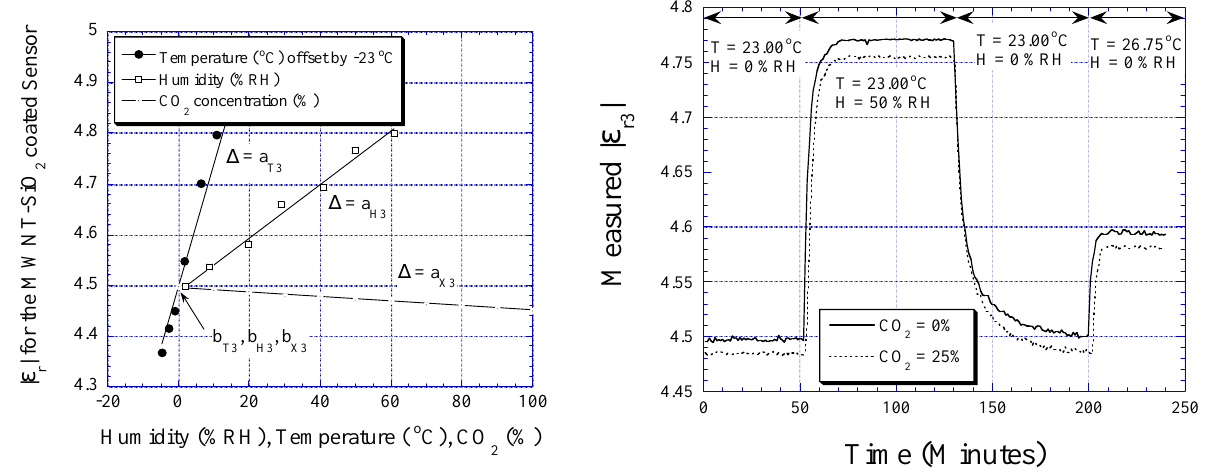
Figure 9. (a) The permittivity magnitude of the MWNT-based CO CO , humidity, and temperature. (b) The permittivity magnitude of the MWNT-based CO 2 sensor, at zero and 25% CO concentration, as it is exposed to different humidity and 2 temperature